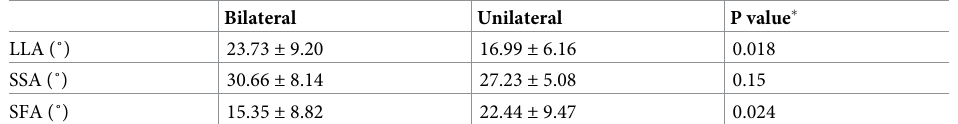
Table 2. Measured data for all patient in each group.